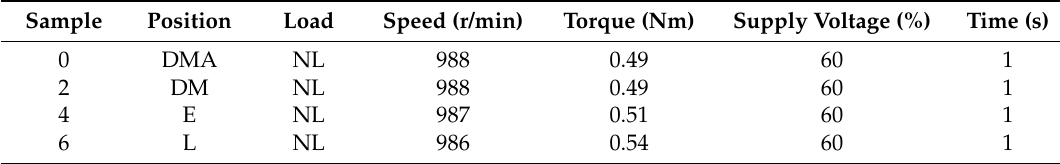
Table 1. Characteristics of the experiment for the healthy motor during start-up.